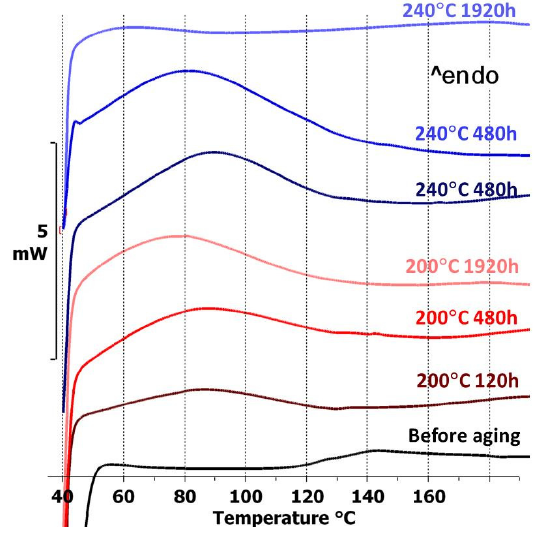
Figure 2. DSC measurements for the FR ‐ 4 test board before and after testing.